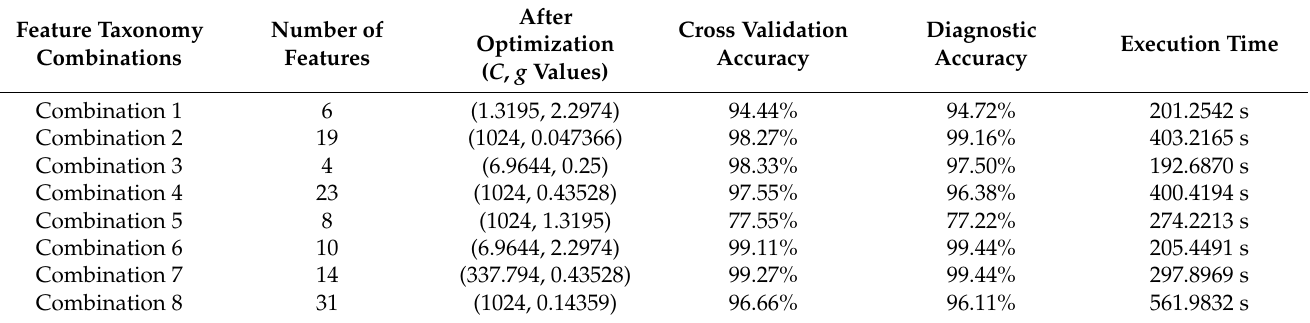
Table 5. The results of the SSAE-SVM classification when different parameter features were